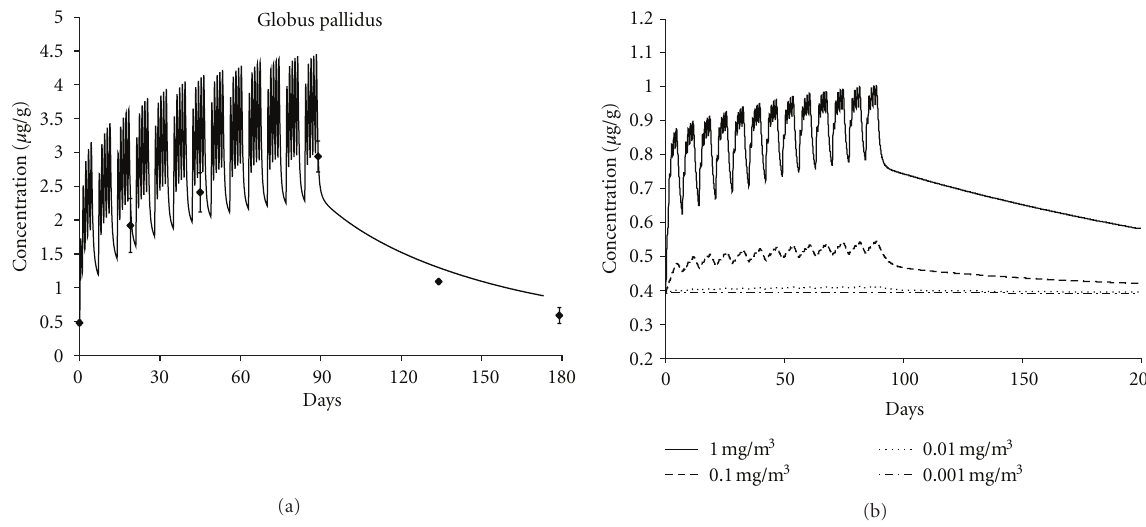
Figure 3: Curves showing simulated end-of-exposure brain tissue manganese concentrations in monkeys (a) and people (b) as a function of inhalation exposure concentration (mg Mn/m 3 ). Simulated exposures are for 90 days (5 days/week) for either 6h/day (monkeys) or 8h/day (human beings). The monkey simulation results at 1.5mg/m 3 (a) are compared with data from Dorman et al. [21] depicted with symbols showing means and standard errors (SEs) from four to six monkeys per time-point. The larger magnitude changes predicted in monkeys compared with humans at higher inhalation exposure concentrations could be due to the saturation of manganese binding sites in the monkey coming from higher manganese concentrations in the diet of the monkeys. Modified from